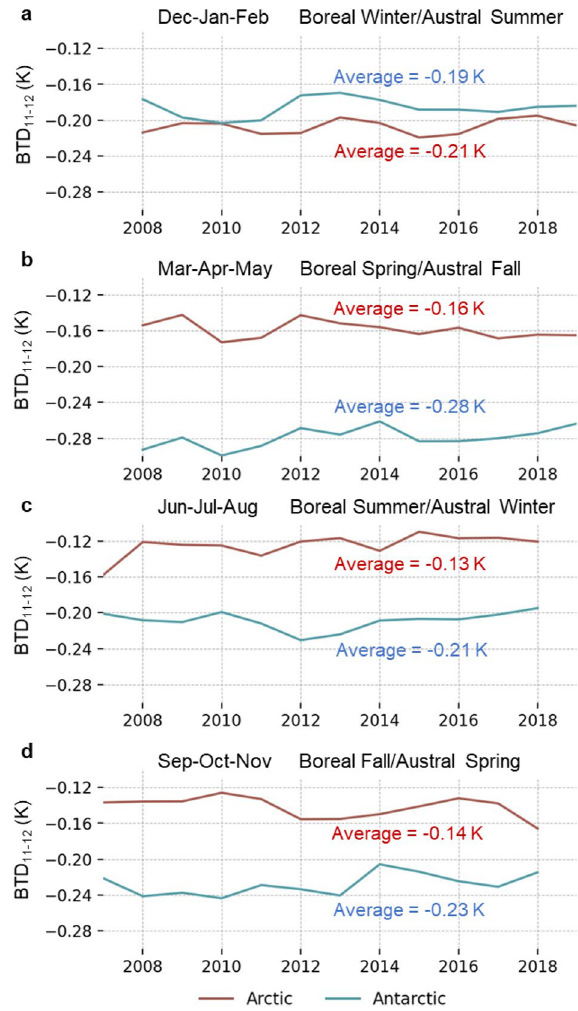
Figure 4. Seasonal BTD 11-12 values from 2007 to 2019 for ( a ) Dec–Jan–Feb, ( b ) Mar–Apr–May, ( c ) Jun–Jul– Aug, and ( d ) Sep–Oct–Nov for the Arctic (red) and Antarctic